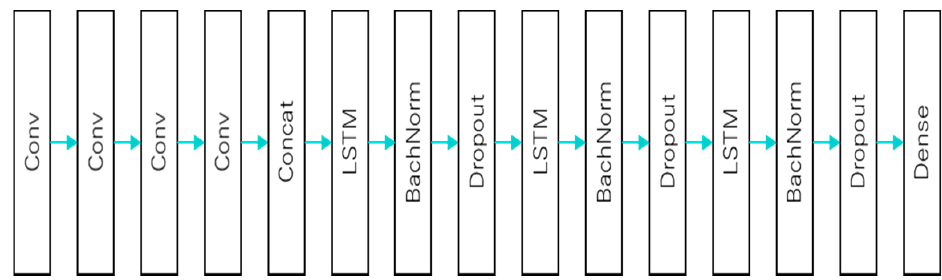
Figure 10. Prediction model layer configuration.